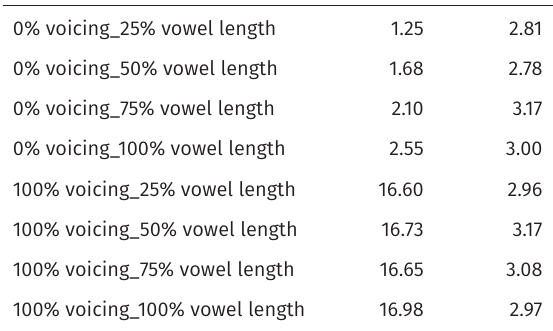
Table 5: Identification rates of [z] in each of the patterns tested (number of tokens per pattern = 18; number of participants = 40).